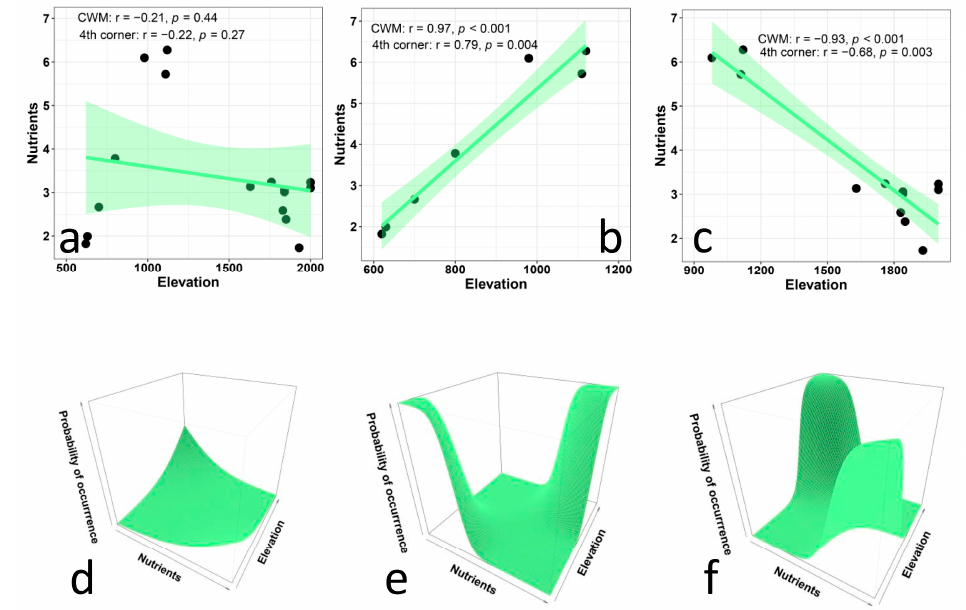
Figure 4. Relationship between Ellenberg indicator values for nutrients and elevation in plant communities along an elevational gradient in Central Italy. The upper panels ( a – d ) present CWM regression models and their statistical corrections using fourth-corner analysis for the entire gradient ( a ), for the lower subgradient ( b ), and for the upper subgradient ( c ). The lower panels ( d – f ) illustrate the results of multi-level models for the entire gradient ( d , trait × environment interaction p < 0.01, marginal R 2 = 0.01), for the lower subgradient ( e , trait × environment interaction